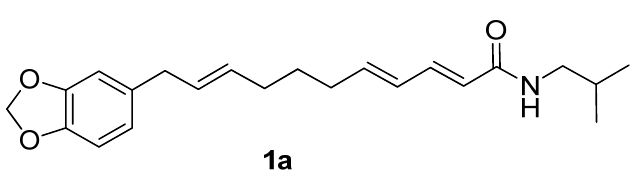
Figure 1. Structure of laetispicine.